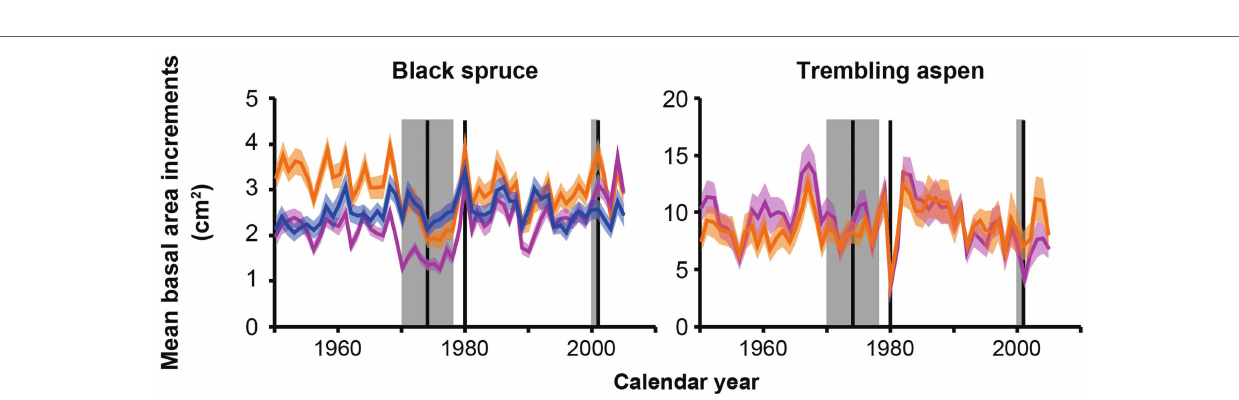
FIGURE 4 | Mean BAIs for black spruce and trembling aspen from 1950 to 2005. The blue curve represents mean BAI in pure black spruce stands (PBS), the orange curves represent mean BAI in mixed stands, and the purple curves represent mean BAI in pure trembling aspen stands (PTA). The colored areas represent ±1 SEM. The gray areas and black vertical lines correspond to the spruce budworm epidemic centered around 1974, and the forest tent caterpillar (FTC) epidemics of 1980 and 2000–2001 (Bergeron et al., 2002; Ministère des Forêts, de la Faune et des Parcs,